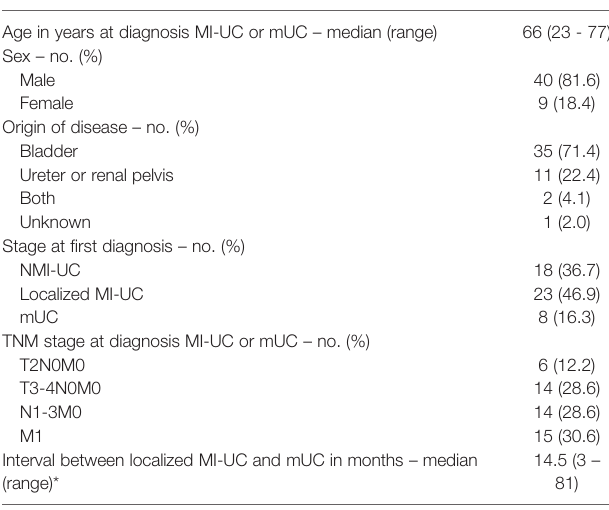
TABLE 1 | Patient